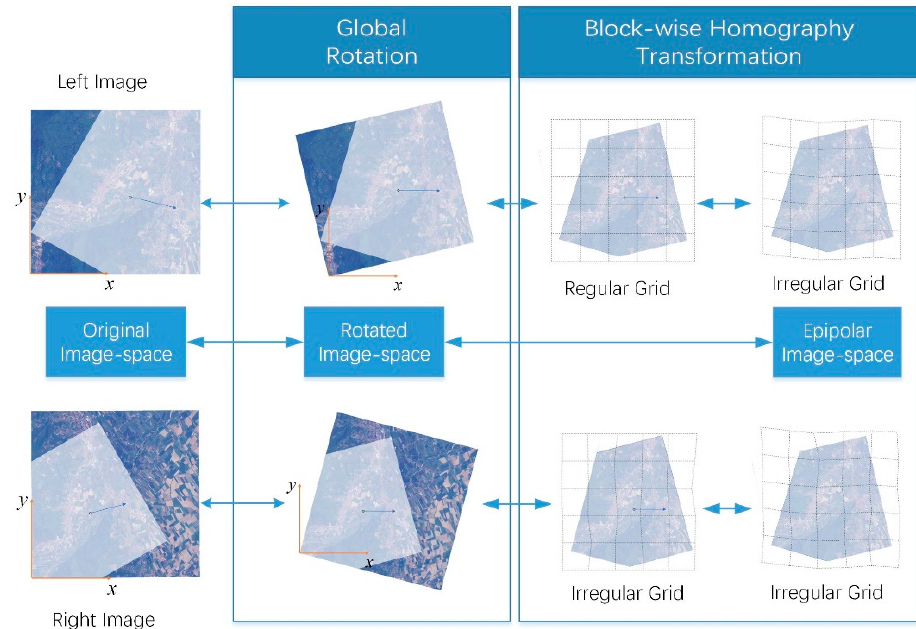
Figure 3. The process of transforming points between the original image-space and the epipolar image-space in the proposed approach.